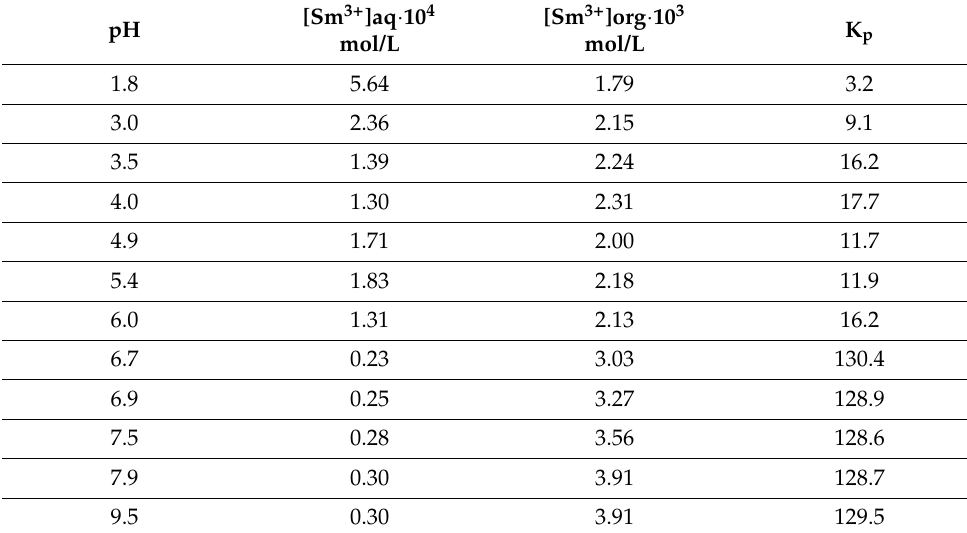
Table 1. The results of the experimental study of samarium ions’ distribution between aqueous and organic